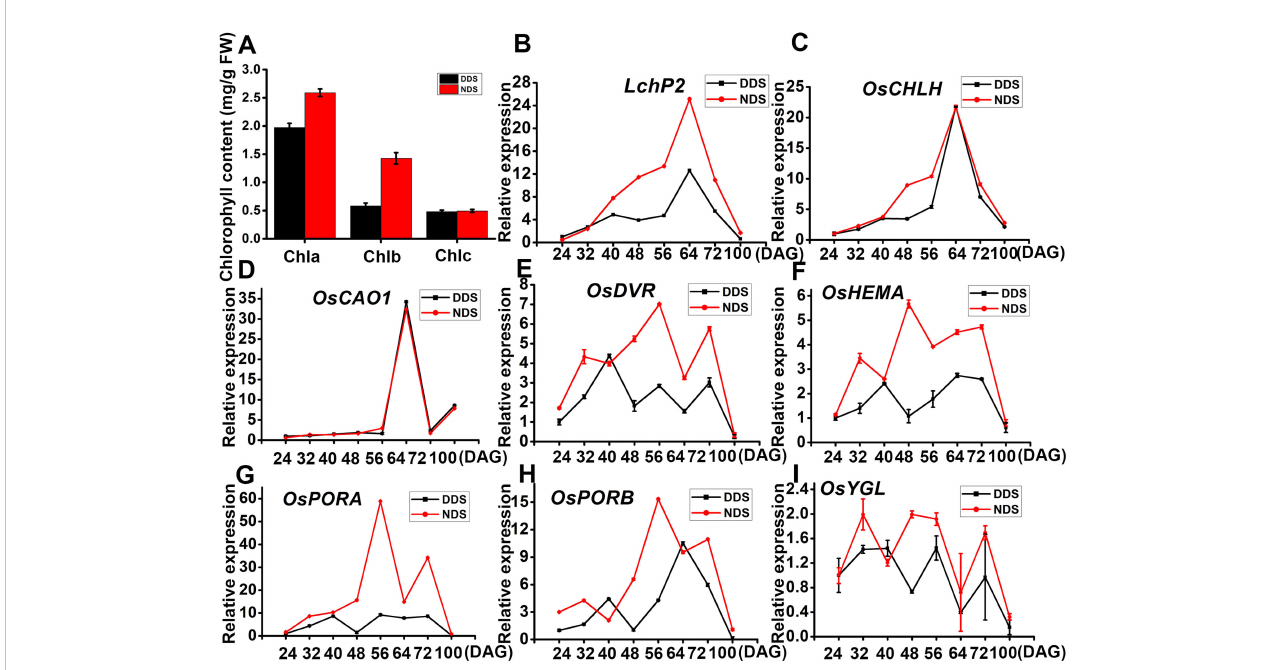
FIGURE 6 Relative expression of genes related to chloroplast development in leaves from DDS and NDS. (A) Content of photosynthetic pigments in fl ag leaves from DDS and NDS plants. (B-I) A qRT-PCR analysis of temporal expression in the whole plant with genes associated with chlorophyll synthesis (i.e., LchP2, OsCHLH, OsCAO1,OsDVR, OsHEMA, OsPORA, OsPORB , and OsYGL ) between DDS and NDS plants at 24 、 32 、 40 、 56 、 64 、 72 、 100 DAG. Error bars represent mean ± SD (n = 3) where the different letters indicate statistical differences according to Duncan ’ s multiple range test (p ≤ 0.05).